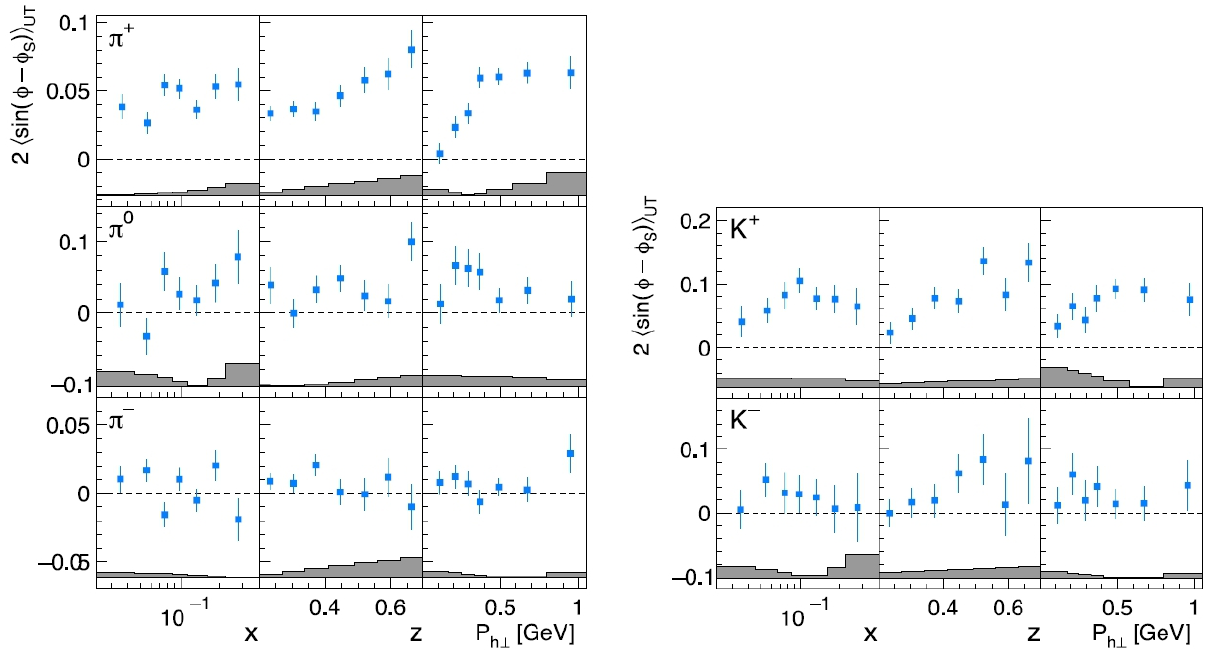
Figure 8. HERMES measurements of the Sivers asymmetries on protons for π ± (left) and K ± (right).